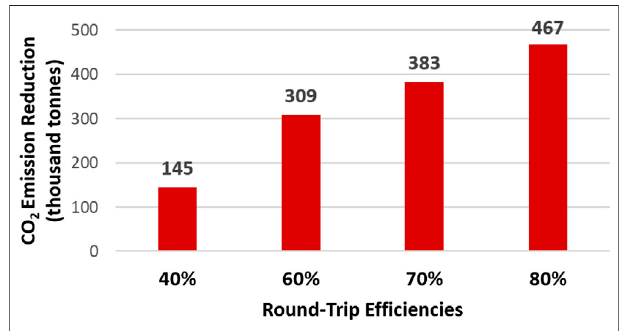
FIGURE 18 | Annual CO 2 emission reduction associated with the maximumbene fi tlong-durationenergystorageincludingenergystorageswith (A) 40% round-trip ef fi ciency and 9-day duration, (B) 60% round-trip ef fi ciencyand24-dayduration, (C) 70%round-tripef fi ciencyand30-day duration, and (D) 80% round-trip ef fi ciency and 32-day